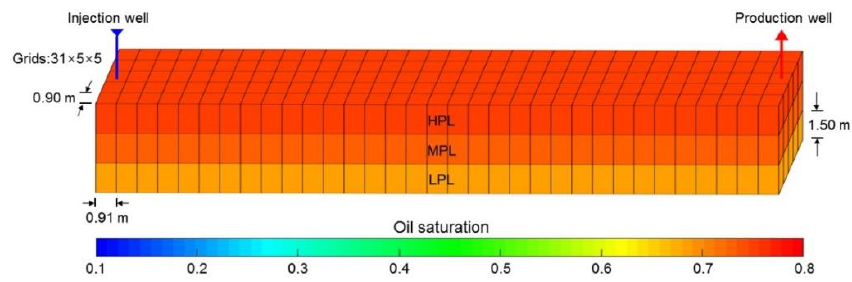
Figure 8. The grid system, well location and 3D distributions of initial oil saturation of Case 1.